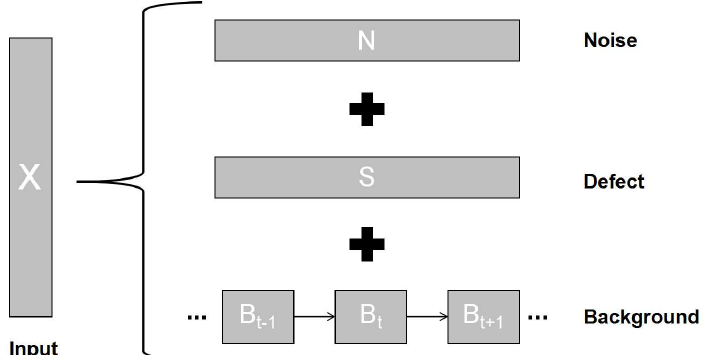
Figure 1. The overall framework of our method. X is the input data, B, S, and N are the corresponding background, defect, and noise